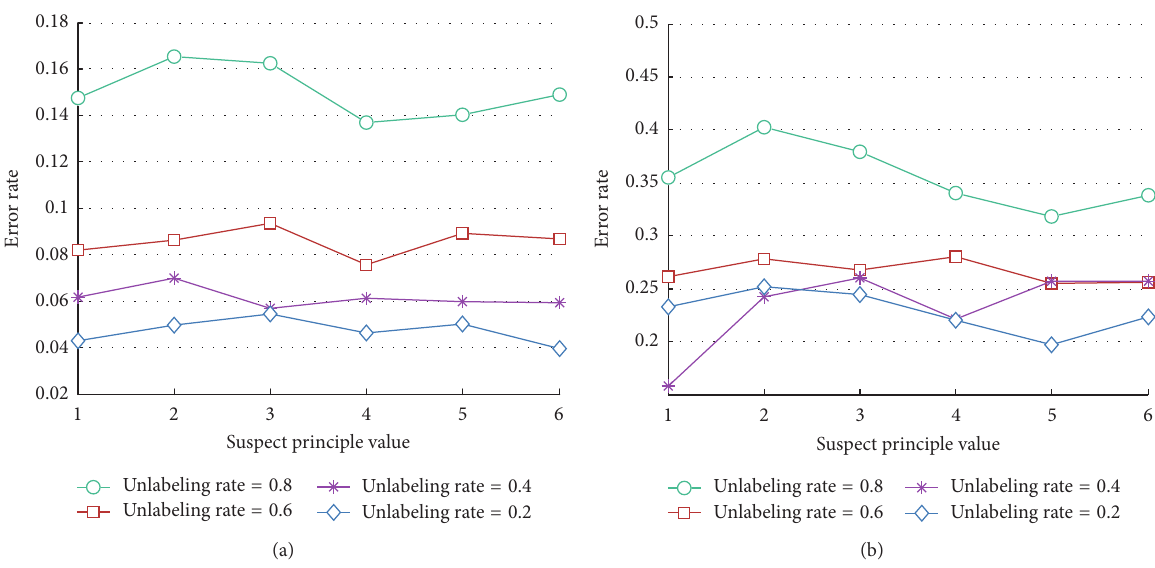
Figure 6: Classification error rate of Case 1 (a) and Case 2 (b) under different unlabeling rate and suspect principle value.